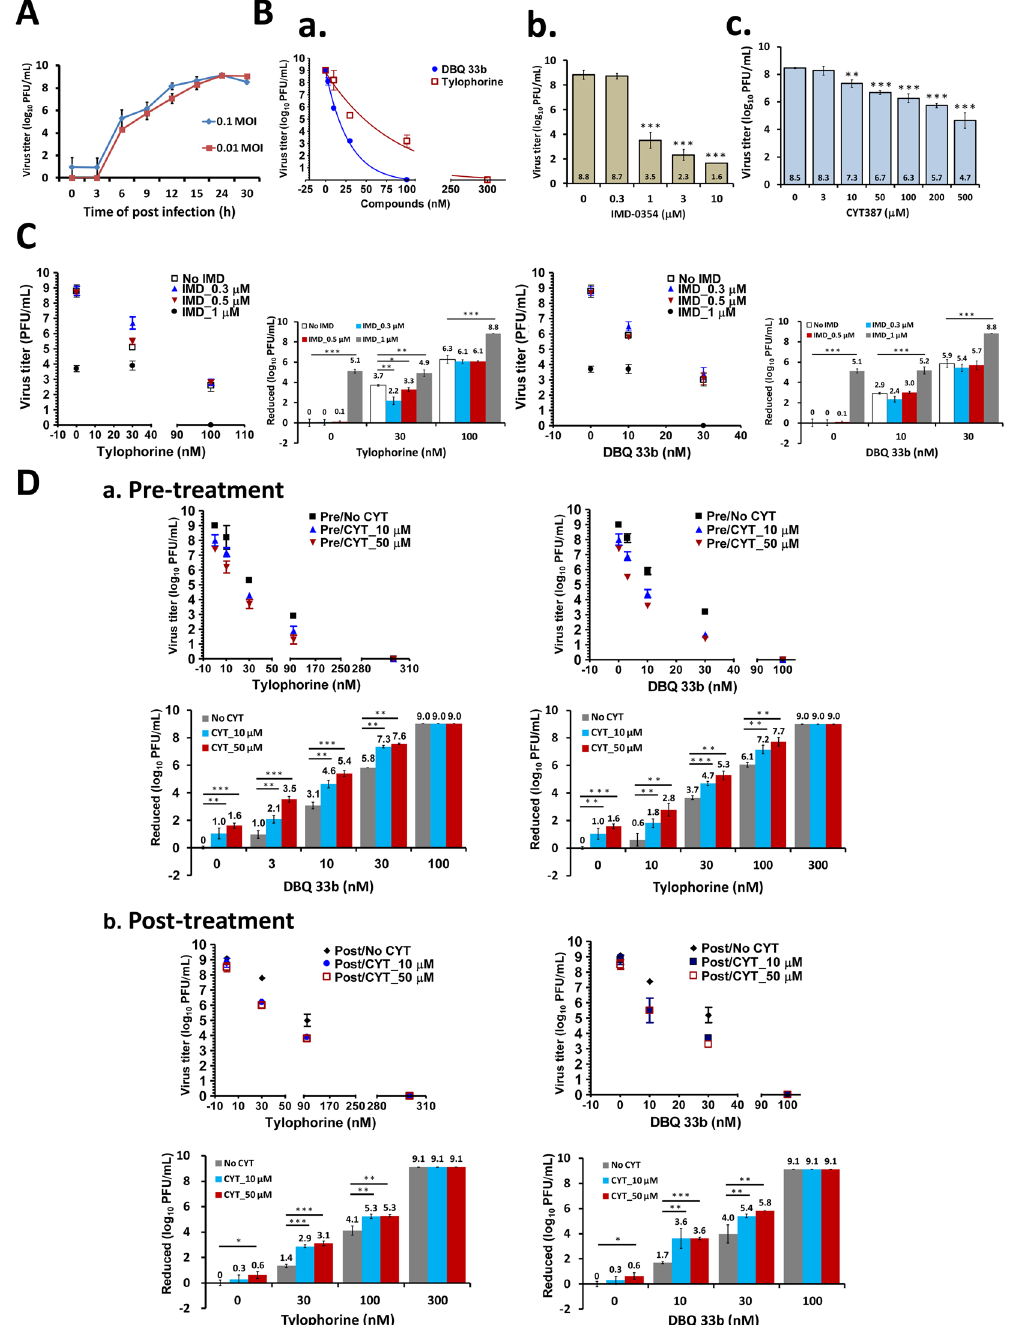
Figure 4. Effects of tylophorine-based compounds, IMD-354, or CYT387 alone or in combination on reducing TGEV yields. ( A ) The kinetics of TGEV replication in ST cells at MOI of 0.1 and 0.01. ( B ) Dose dependent effects of tylophorine compounds, IMD-354, and CYT387 on reducing TGEV yields. ( ** p < 0.01 & *** p < 0.001; versus no compound treatment). ( C ) Combined treatments of tylophorine-based compounds with IMD-354 resulted in an antagonistic reduction in TGEV yields. ( * p < 0.05). ( D ) Combined treatments of tylophorine-based compounds with CYT387 resulted in a cooperatively comprehensive reduction in TGEV yields either in pre-treatment (a) or post-treatment experiments (b). ( * p < 0.05 & ** p < 0.01 & *** p < 0.001) ST cells were seeded the day before compound treatment or TGEV infection. The tested compounds were added to the wells 1 h prior to ( B , C , D –a) or after ( D –b) the addition of TGEV at an MOI of 0.01. The resultant cultures were then incubated for an additional 3–30 h ( A ) or 15 h ( B , C , D ) at 37 °C as indicated. The supernatant of cells in each specific treatment was collected and subjected to viral titer determination via an end-point dilution assay conducted with ST cells. Results shown were means ± S.D. from three or more independent